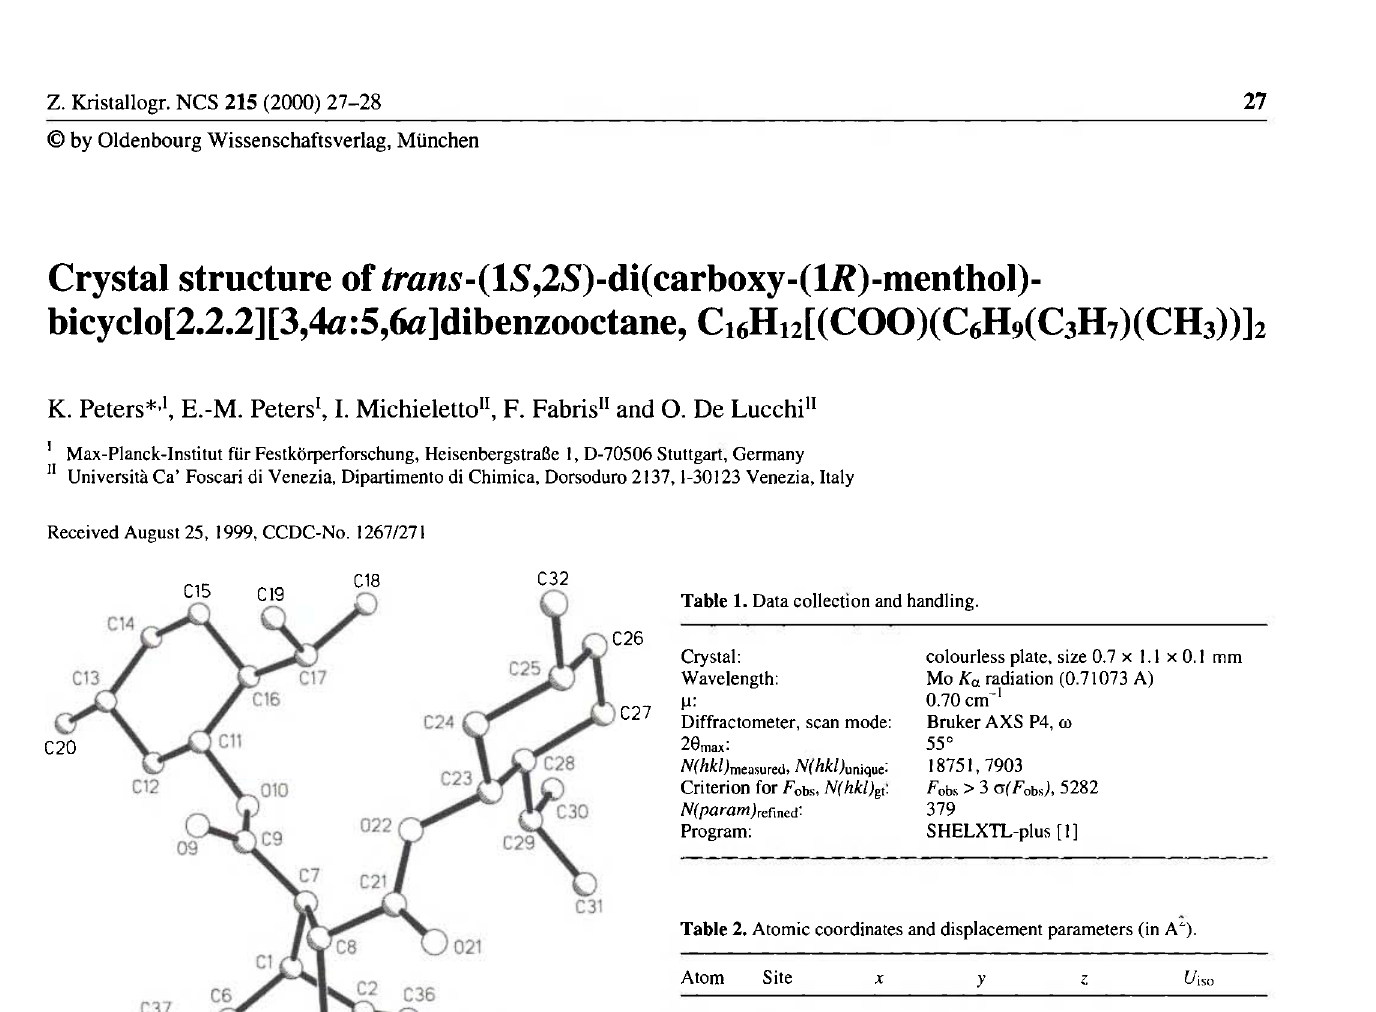
Table 2. Atomic coordinates and displacement parameters (in A